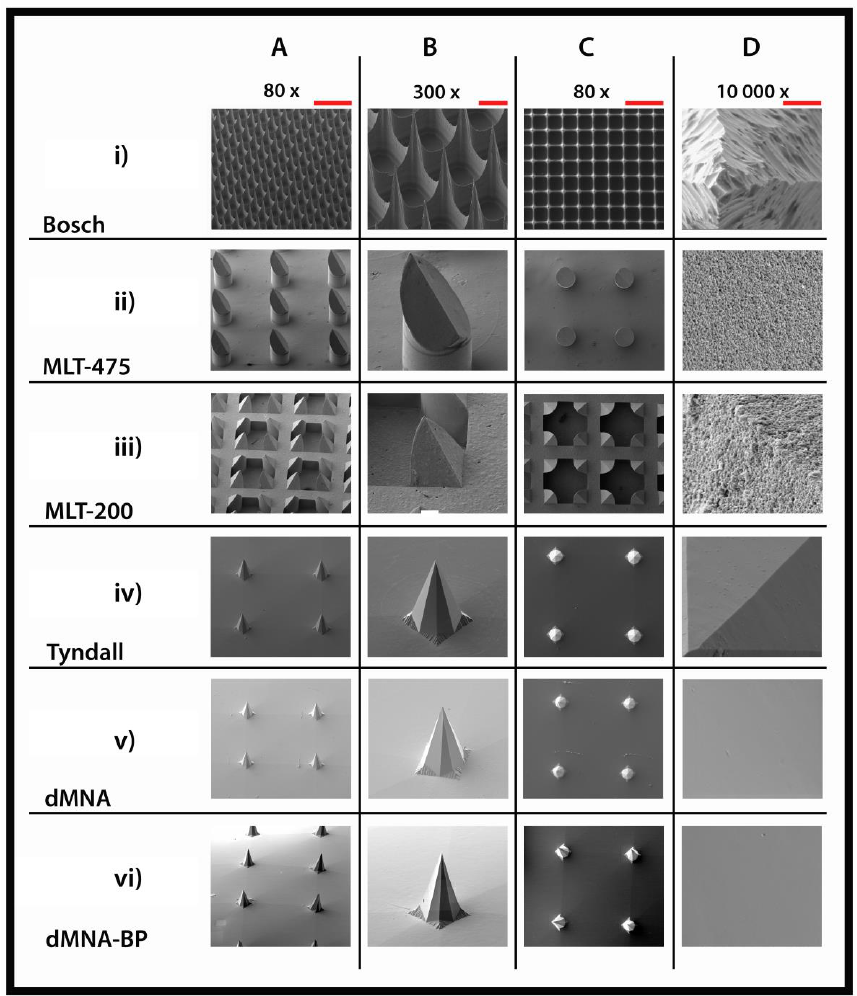
Figure 5. Scanning electron microscopy images of microneedle arrays (MNAs) with different geometries and lengths: Bosch of 320 µm ( i ), MLT-475 of 475 µm ( ii ), MLT-200 of 200 µm ( iii ), and Tyndall ( iv ) dMNA ( v ) and dMNA-BP ( vi ) of 300 µm. MNAs were imaged from a lateral view ( A , B ), and from the top side ( C , D ). Scale bars represent 500 µm (80×) ( A , C ), 100 µm (300×) ( B ), and 4 µm (10,000×) ( D ). Table 2. Microneedle tip diameters of different MNAs measured using the SEM images. Data are shown as mean ± SD, n = 5 (except Tyndall, dMNAs and dMNAs-BP with n = 4). Bosch MLT-200 MLT-475 Tyndall dMNA dMNA-BP Tip diameter (µm) 1.2 ± 0.3